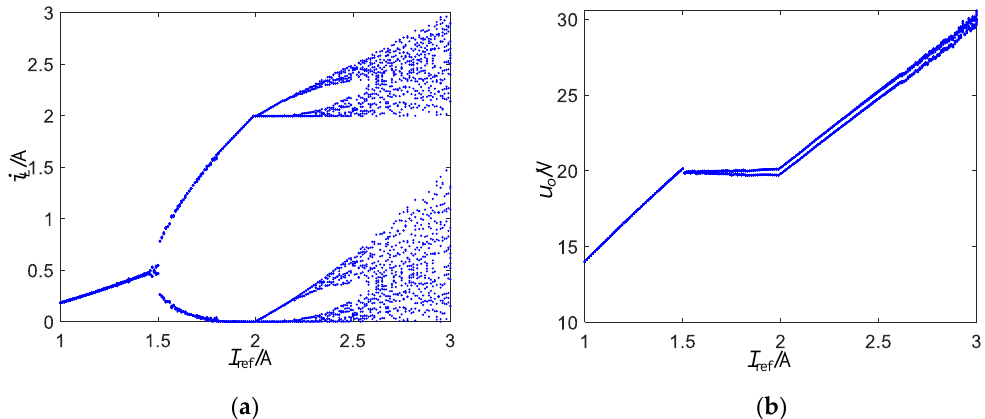
Figure 5. A bifurcation diagram of the integer-order converter with I ref as the bifurcation parameter: